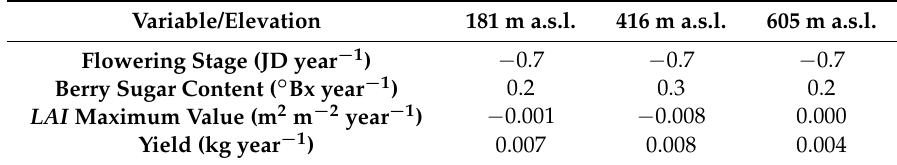
Table 6. Linear regression slopes evaluated for the variables discussed in the text over the most recent 30-year period, 1980–2009, in three grid points with the same soil texture and different